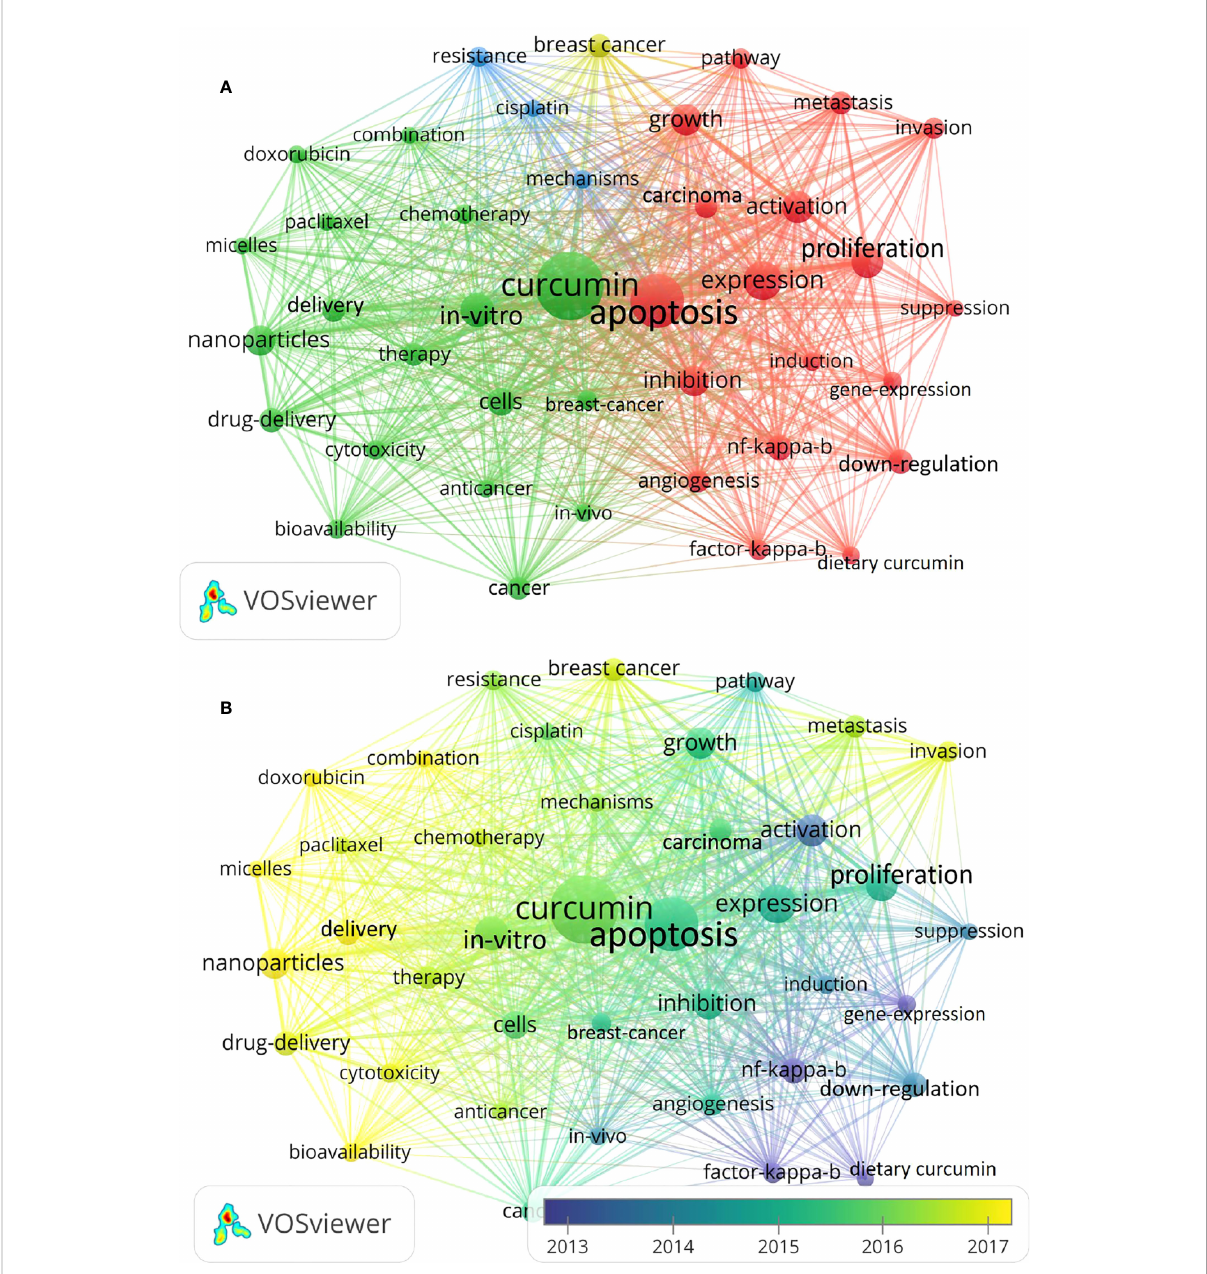
FIGURE 10 Visualization of keyword analysis. (A) The network map of keywords. (B) Evolution of keyword